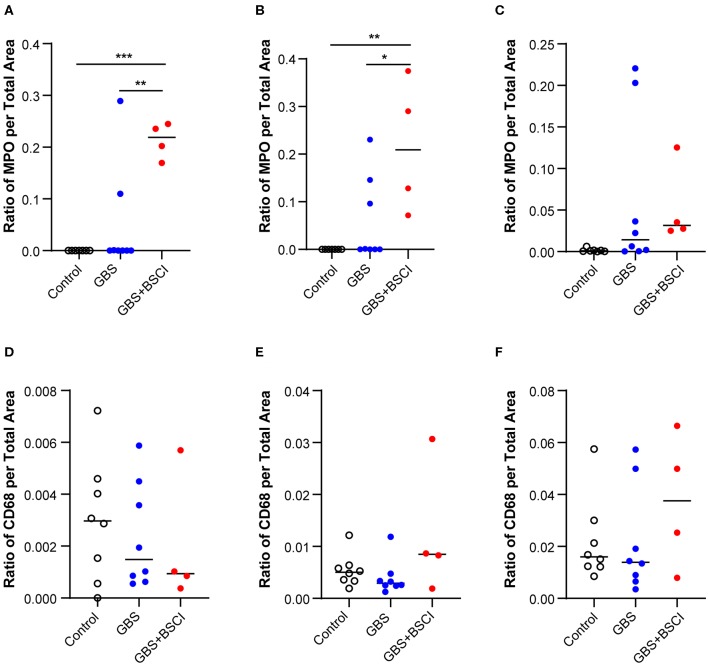
Quantitation of immunostaining for MPO and CD68 in the chorioamniotic membranes. The area of immunostaining for MPO (A–C) and CD68 (D–F) are shown in the amnion (A,D), chorion (B,E), and decidua (C,F). The area of MPO immunostaining in the BSCI vs. GBS alone group was significantly greater in the amnion (A) and chorion (B), but not decidua. No significant differences were observed in the area of CD68 immunostaining between the BSCI and GBS alone groups in the chorioamniotic membranes. The outlier in the saline group in (D,F) was a newer saline control performed as part of this study and the next two highest controls were previously published (72). *p < 0.05, **p < 0.01, ***p < 0.001, one-way ANOVA with Tukey's post-hoc correction.